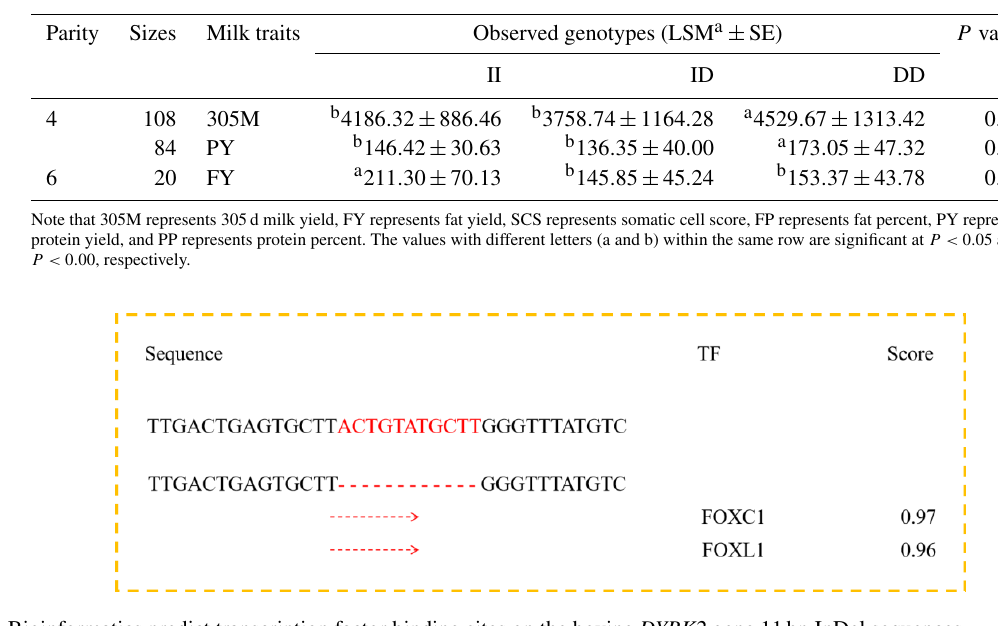
scription (Van et al., 2003; Fushan et al., 2009). Therefore, we used the online software Jaspar Genereg